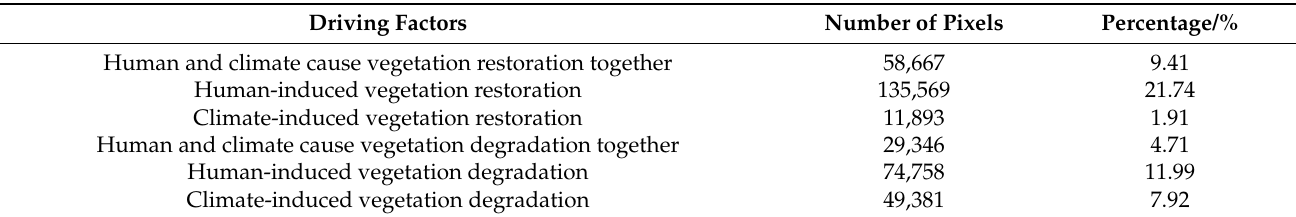
Table 9. Analysis of driving factors of vegetation quality changes on the Loess Plateau from 1990 to 2015.